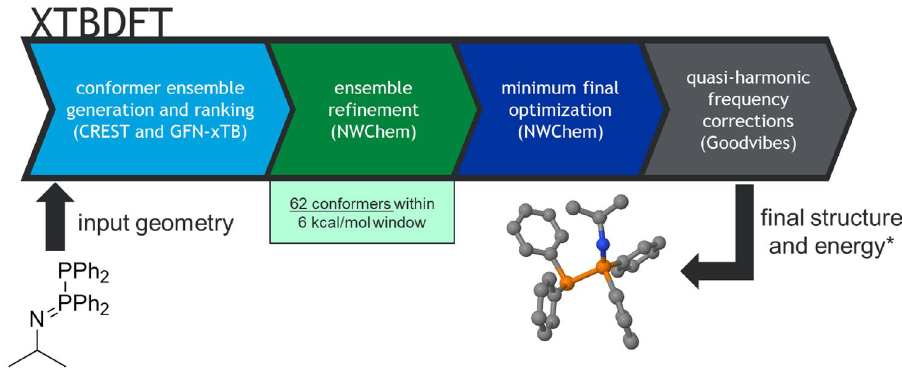
Figure 1. XTBDFT flowchart with example input and